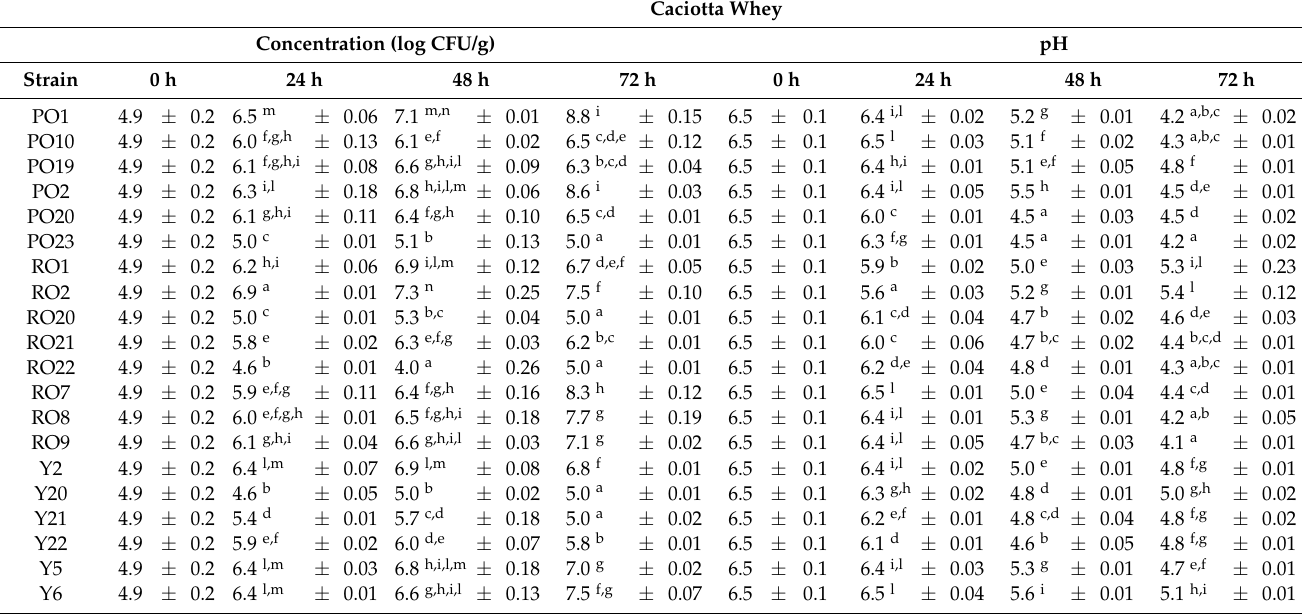
Table 2. Concentrations of Y. lipolytica in caciotta whey and pH over time. Results are the mean of three different measurements. Different letters mean significant differences ( p < 0.05) within a